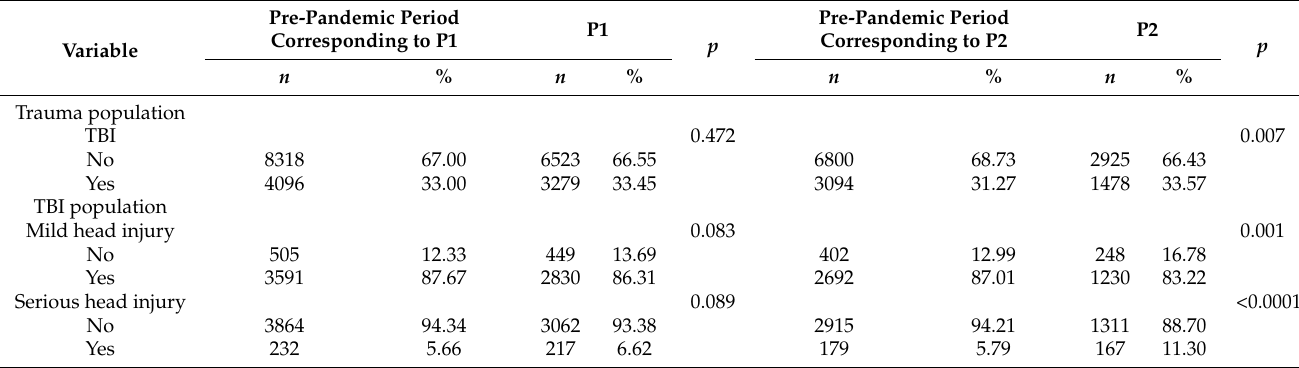
Table 1. Comparison of the proportions of TBI-related ED visits and injury patterns before and after the COVID-19 pandemic.